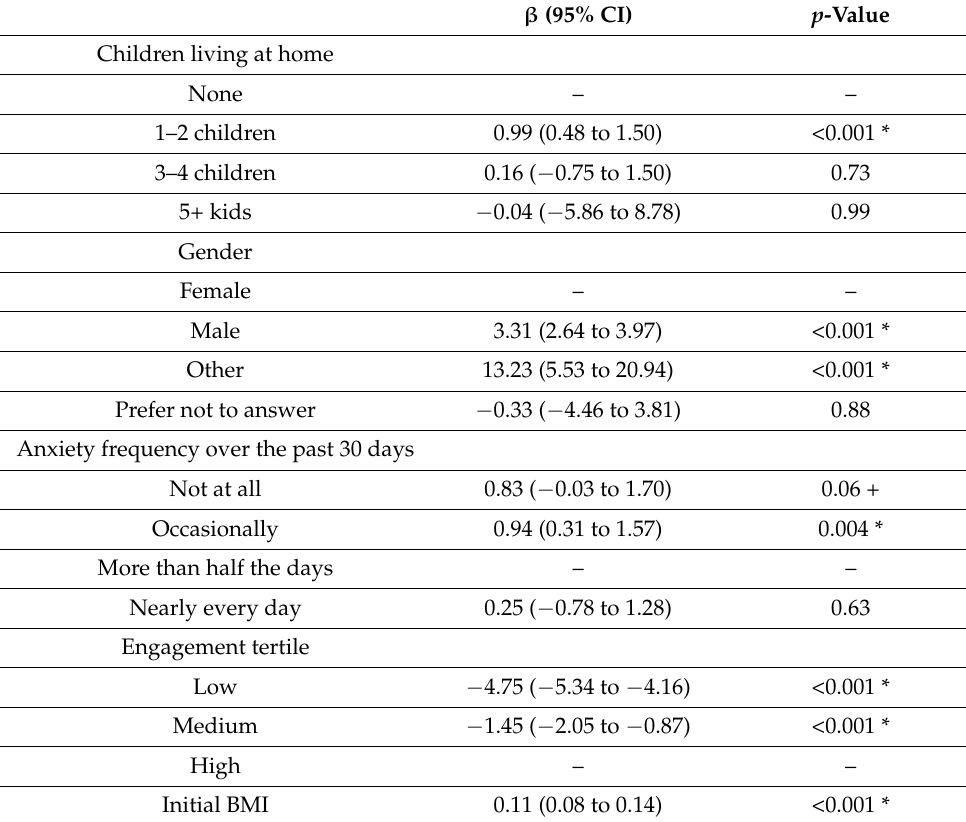
Table 4. Backward stepwise regression model predicting weight loss at week 17 ( n = 1025). β (95% CI) p